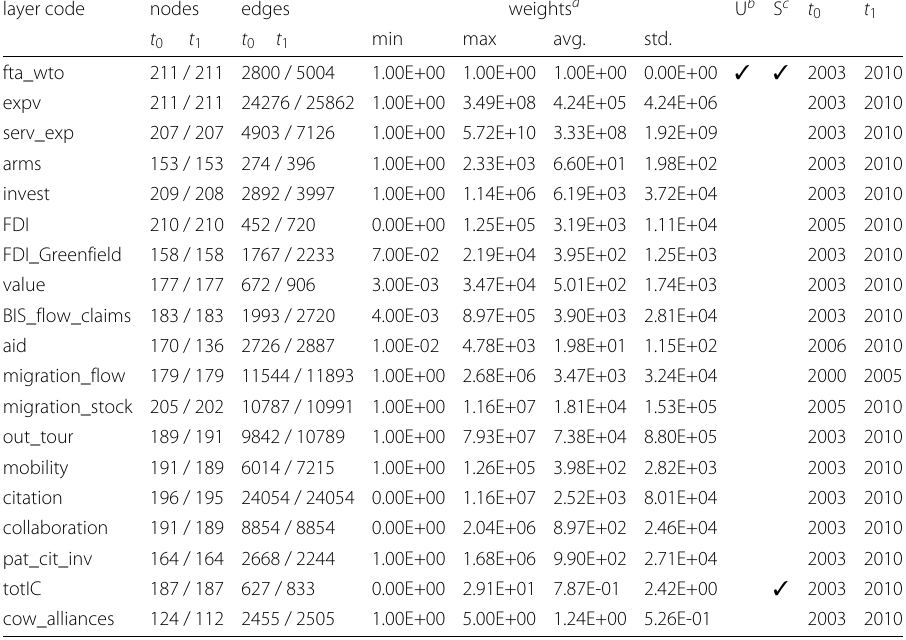
Table 1 Variable summary: descriptive statistics of the raw